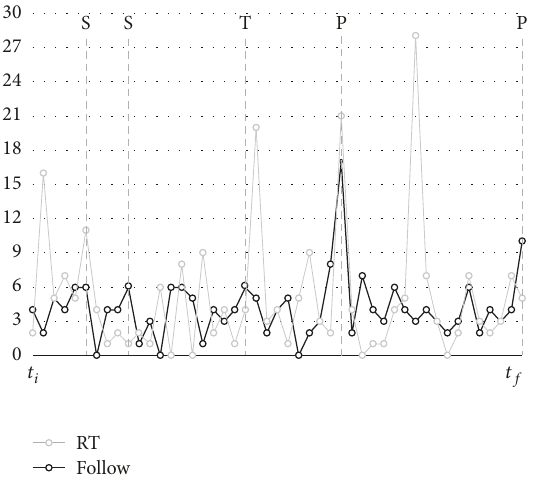
Figure 3: Correlation that exists between RTs and follows.